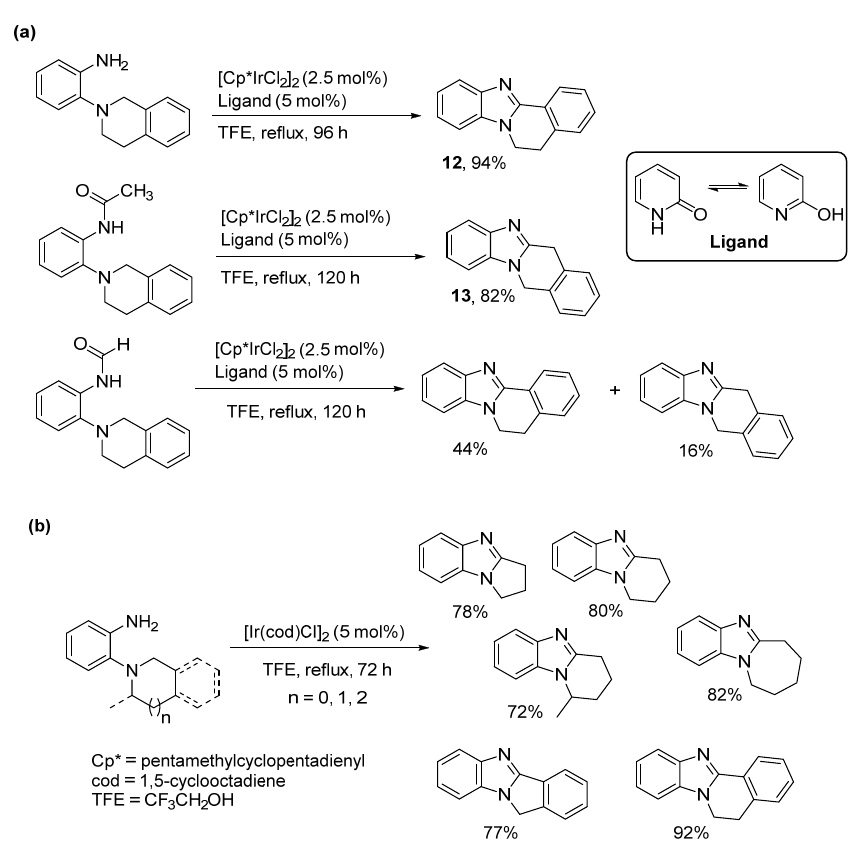
Scheme 6. Ir(III)-mediated cyclizations ( a ) with ligand [47] and ( b ) without ligand [48].